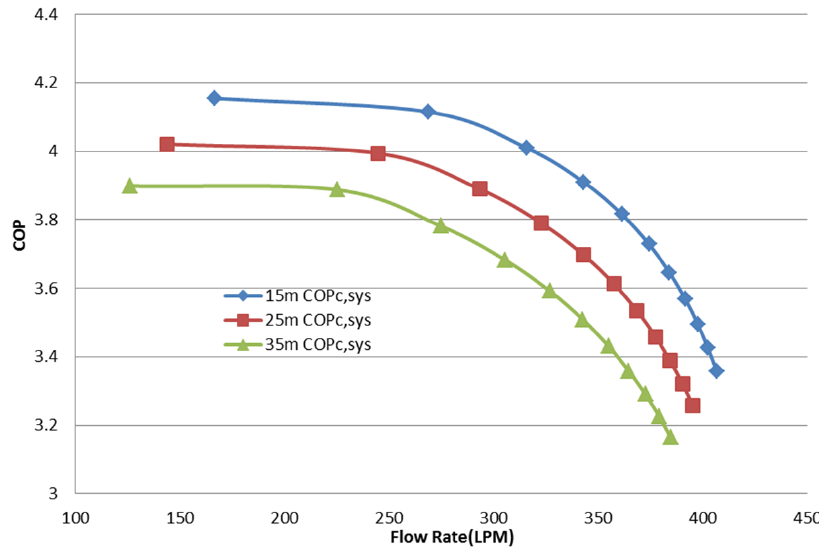
Figure 5. Cooling system COP variation with the flow rate.